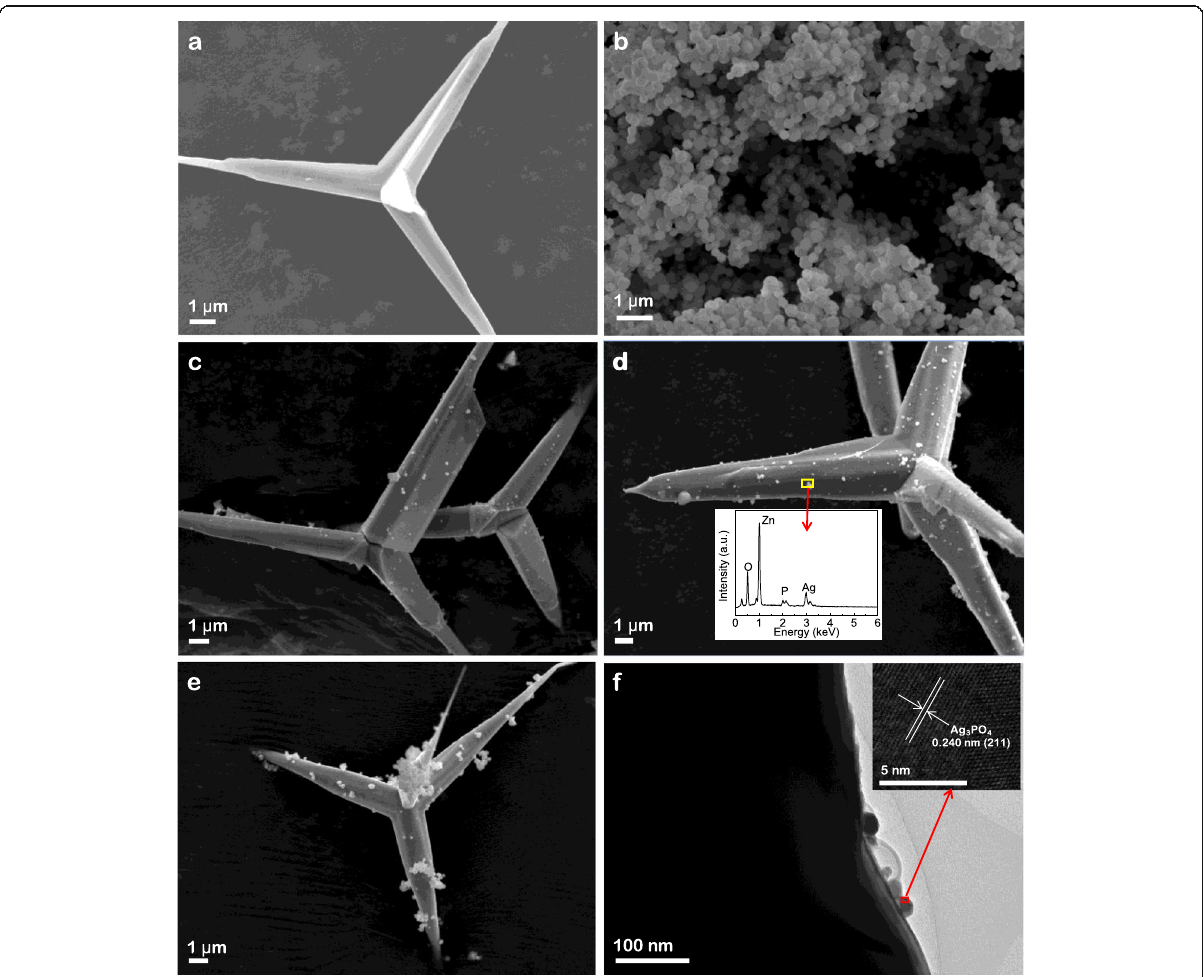
Fig. 2 SEM images of a T-ZnOw, b Ag 3 PO 4 , c Ag 3 PO 4 /T-ZnOw-1, d Ag 3 PO 4 /T-ZnOw-2 (the inset showed the EDS spectrum of the selected area), e Ag 3 PO 4 /T-ZnOw-3, and f TEM image of Ag 3 PO 4 /T-ZnOw-2 (the inset showed the HRTEM image of the red rectangle